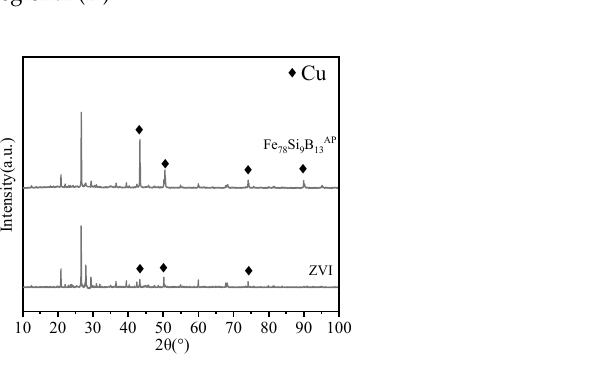
Figure 3. Morphology of the products after the reaction of three materials with Cu 2+ ions: ( a ) Fe 78 Si 9 B 13 AP ; ( b ) high resolution image of regional (B); ( c ) ZVI; ( d ) high resolution image of regional (D).